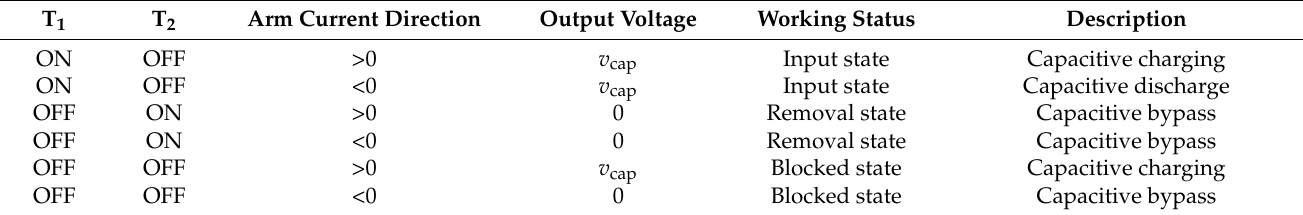
Table 1. The output voltage and switch state corresponding to the power switching device. T 1